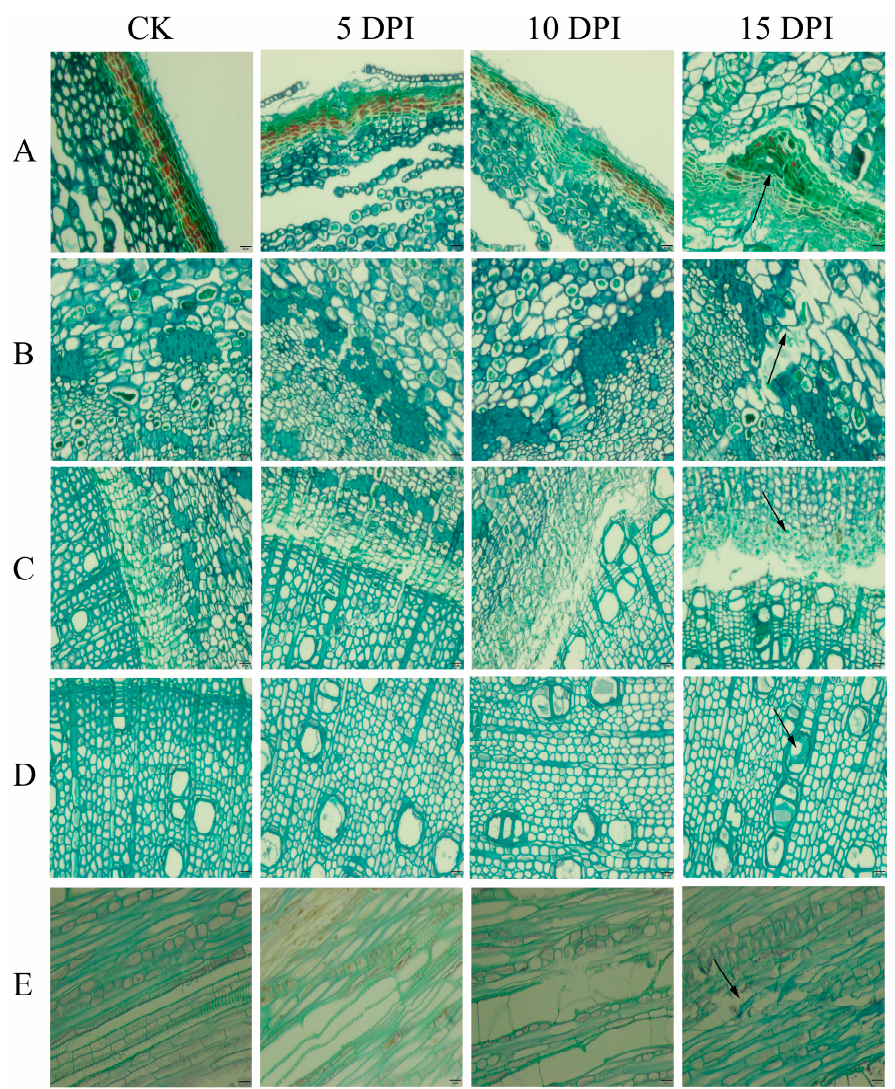
Figure 1. Paraffin sections of uninfected CK and 5 DPI, 10 DPI, 15 DPI walnut branches. The scale bar in the figure is 20 µ m. Note: ( A ): periderm; ( B ): phloem; ( C ): cambium; ( D ): xylem cross section; and ( E ): xylem longitudinal section.